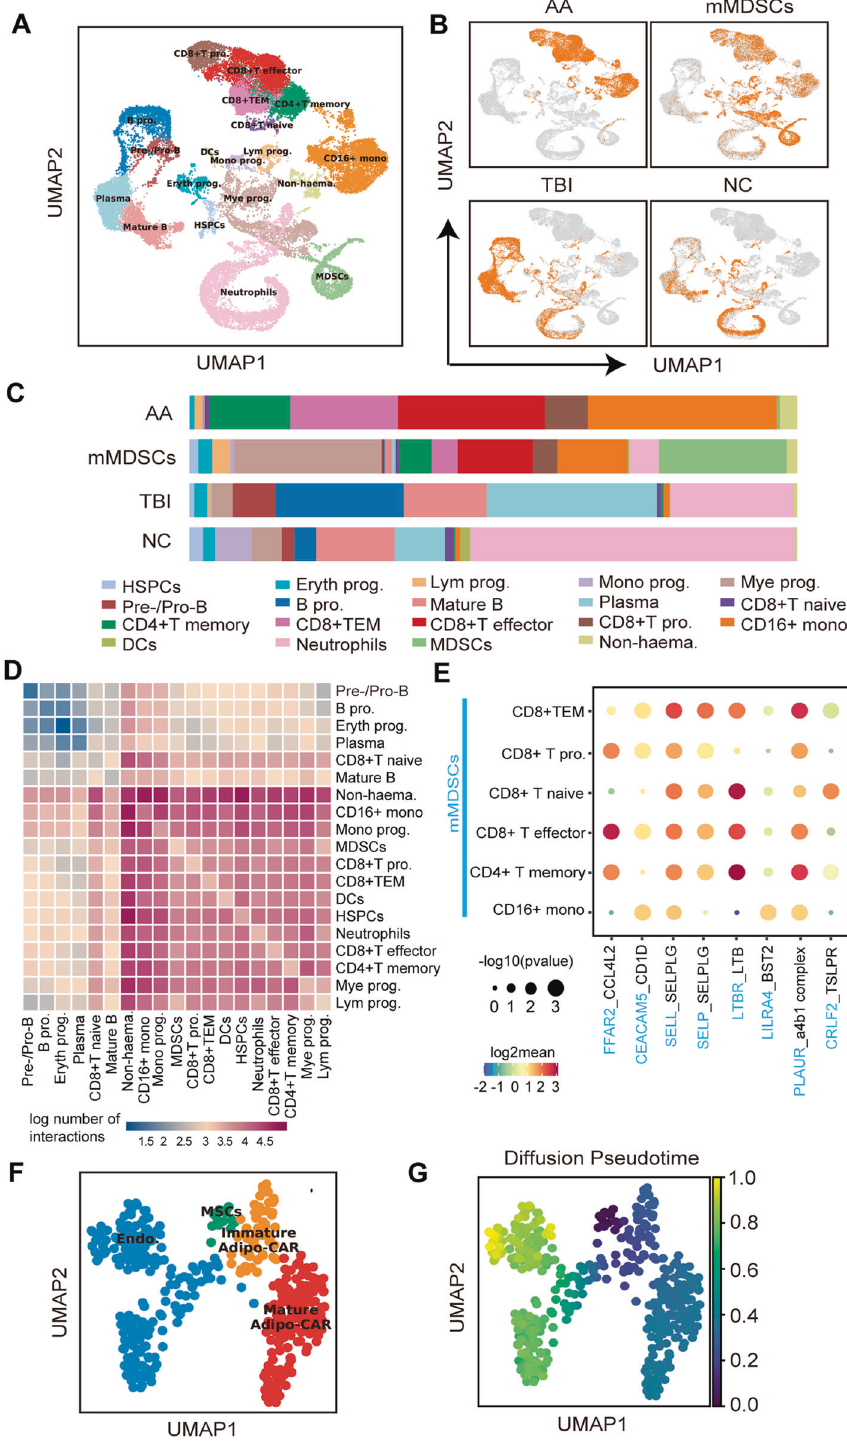
Fig. 6 Identi fi cation of the relationship between different BM population by scRNAseq. A UMAP embedding a total of 34,308 BM cells which were pooled from AA mice ( n = 2), mMDSCs-treated mice ( n = 2), TBI mice ( n = 2), and NC mice ( n = 2) (Eryth prog.: erythroid progenitors; Lym prog.: lymphomyeloid progenitors; Mono prog.: monocyte progenitors; Mye prog.: myeloid progenitors; HSPCs: hematopoietic stem/progenitor cells; MDSCs: myeloid-derived suppressor cells; B pro.: B-proliferation; CD8 + TEM: CD8 + effector memory T cell, CD8 + pro.: CD8 + proliferating cell, Non-haema: non-hematopoietic cells) B UMAP independently embedding BM cells from AA mice ( n = 2), mMDSCs-treated mice ( n = 2), TBI mice ( n = 2) and NC mice ( n = 2). C The proportion of different population in BM cells from AA mice, mMDSCs-treated mice, TBI mice, and NC. D Heatmap depicting the log number of all possible interactions between various populations. E Dot plot depicting selected interactions between MDSCs and various immune response cellular populations in the BM microenvironment. F UMAP embedding different non-hematopoietic cell populations (Endo: endothelial cells, MSCs: mesenchymal stem cells, CAR: Cxcl12-abundant reticular cells). G UMAP embedding non-hematopoietic cells colored by the distance of diffusion pseudotime.